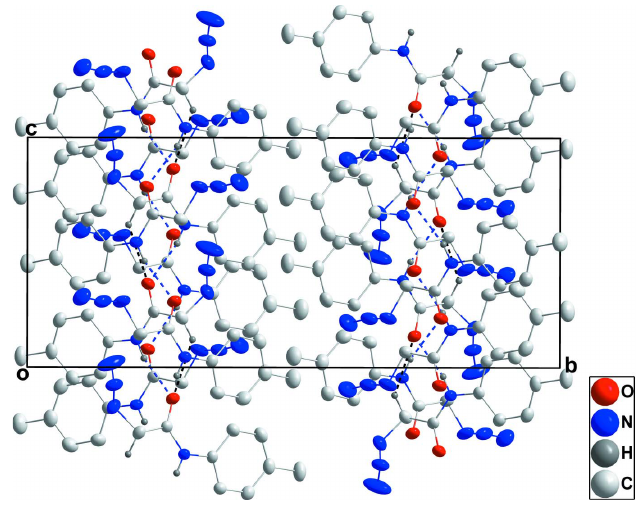
Figure 1 The asymmetric unit with the labelling scheme and 50% probability ellipsoids. The intramolecular C—H (cid:4)(cid:4)(cid:4) O hydrogen bonds are shown as dashed lines.